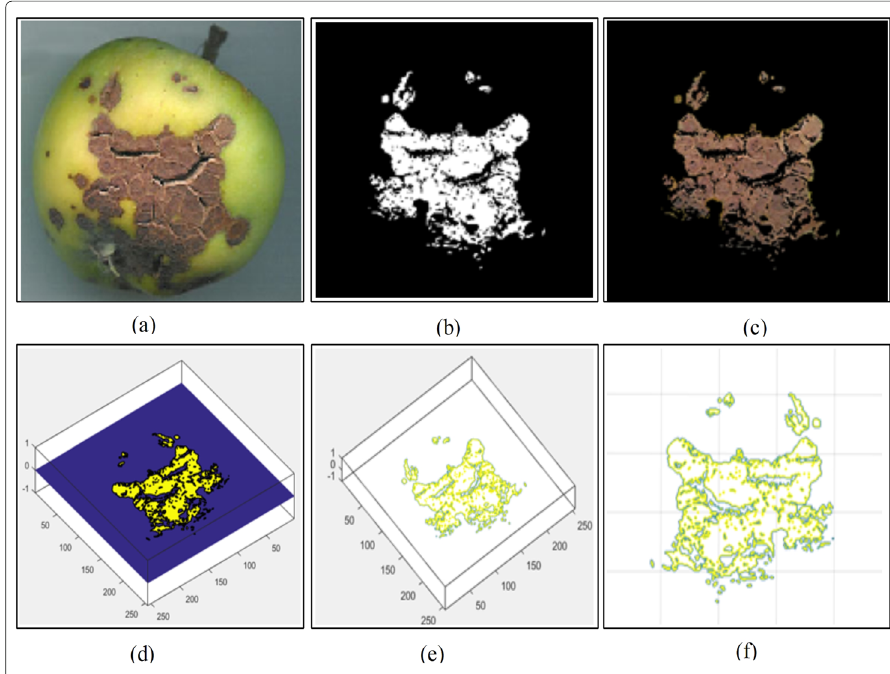
Fig. 6 Proposed Q.D-based segmentation results. a Original image. b Segmented image. c Infection part mapped on the original image. d Contour image under mesh graph. e Contour of infection. f 3-D contour